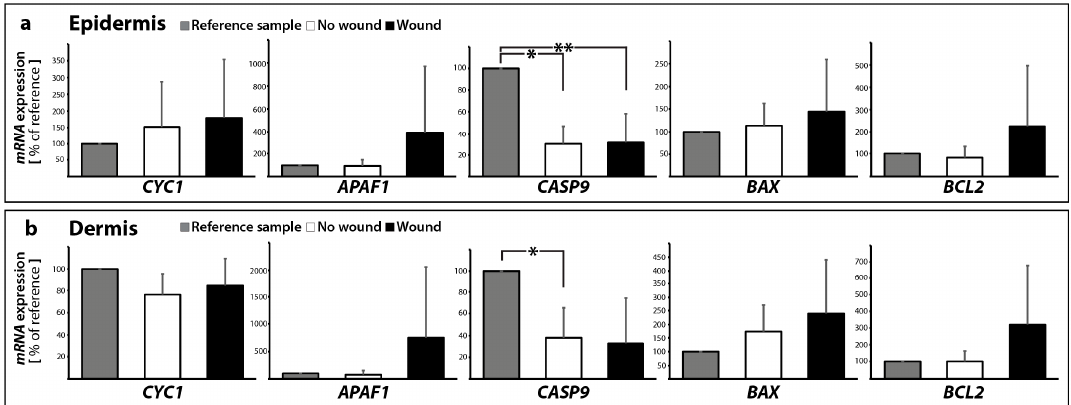
Figure 7. Quantitative real-time PCR of key factors involved in the intrinsic pathway of apoptosis: CYC1 , APAF1 , CASP9 , BAX , and BCL2 were investigated for epidermis ( a ) and dermis ( b ) samples, respectively; * p < 0.05 reference vs. no wound, ** p < 0.05 reference vs. wound.